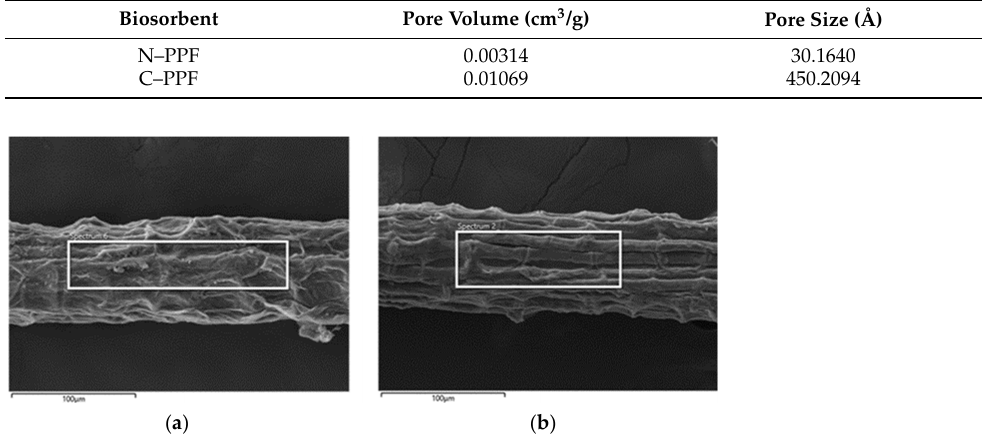
Figure 2. The SEM images show the surface morphology of N–PPF ( a ) and C–PPF ( b ).